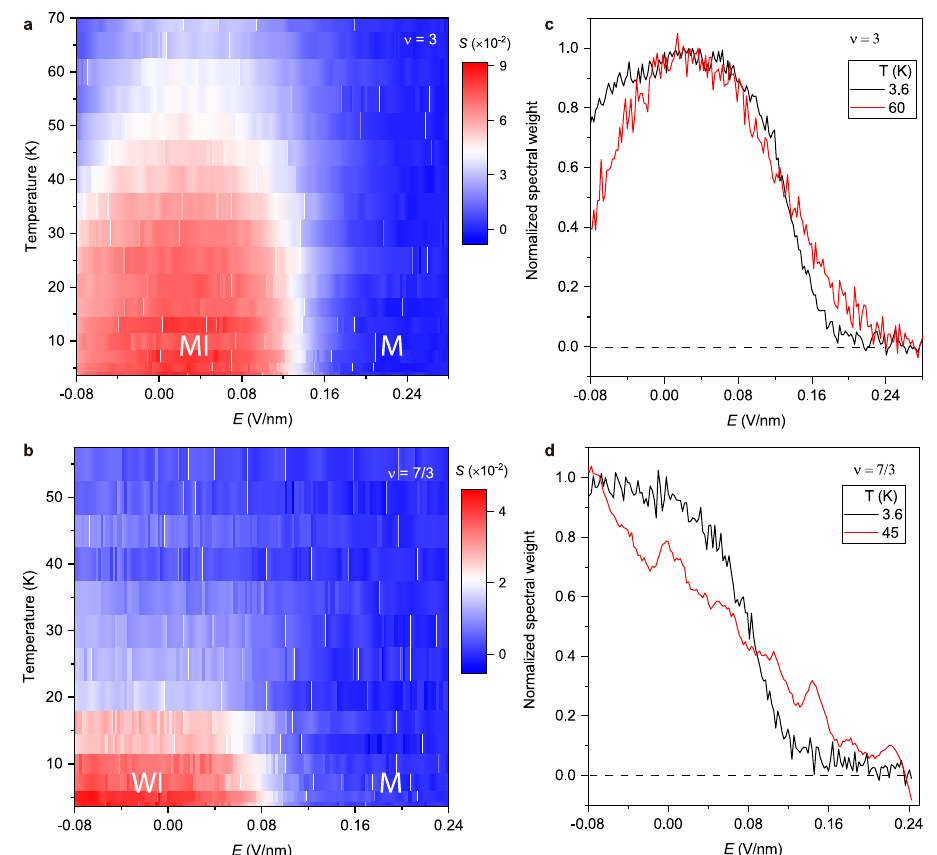
Fig. 4 | Temperature dependence. a , b Contour plot of the sensor 2s spectral weightasafunctionoftemperatureandelectric fi eldfor ν =3( a )and ν =7/3( b ).MI, WI, and M represent, respectively, the Mott insulator, Wigner-Mott insulator, and metal. Regions with enhanced spectral weight (red) correspond to the incom- pressible states (MI and WI); regions with negligible spectral weight (blue)